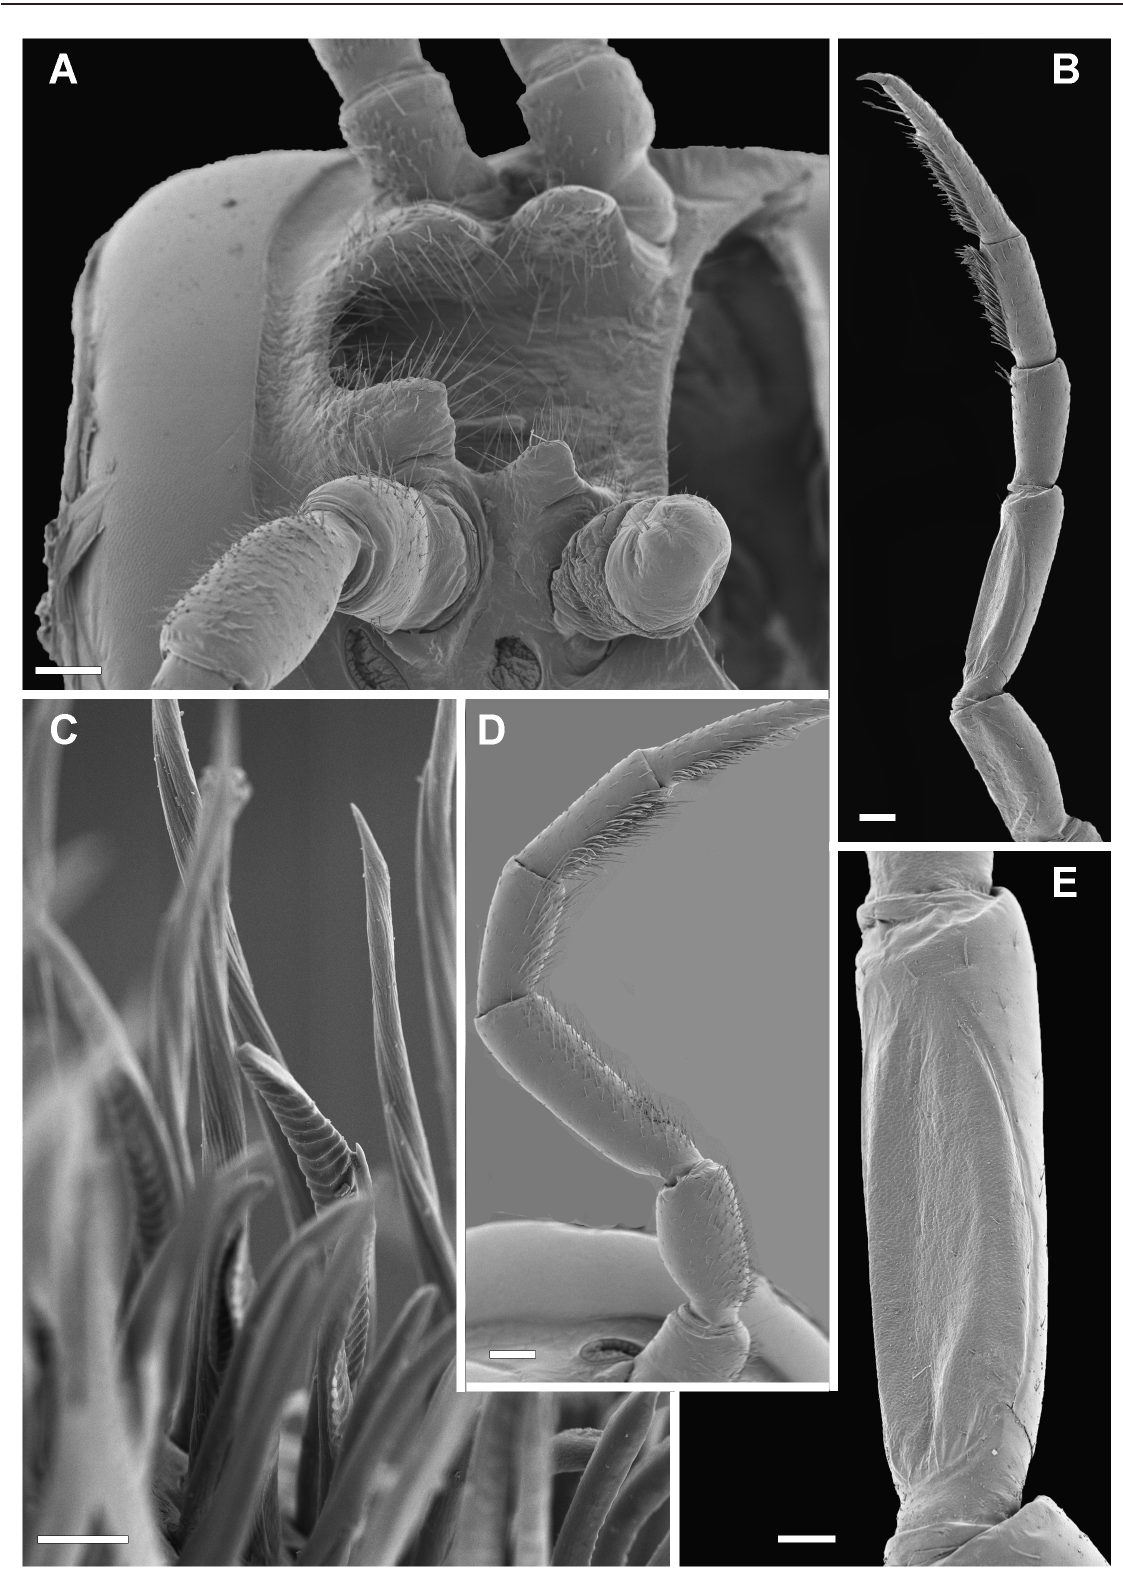
Fig. 28. Eviulisoma kangense sp. nov., paratype. A . Body ring 6, oblique ventral view. B . Post-gonopodal leg. C . Detail of scopula. D . Pre-gonopodal leg (leg from ring 6). E . Femur of post-gonopodal leg, showing smooth, soft ventral surface. Scale bars: A–B, D = 0.2 mm; C = 0.01 mm; E = 0.1